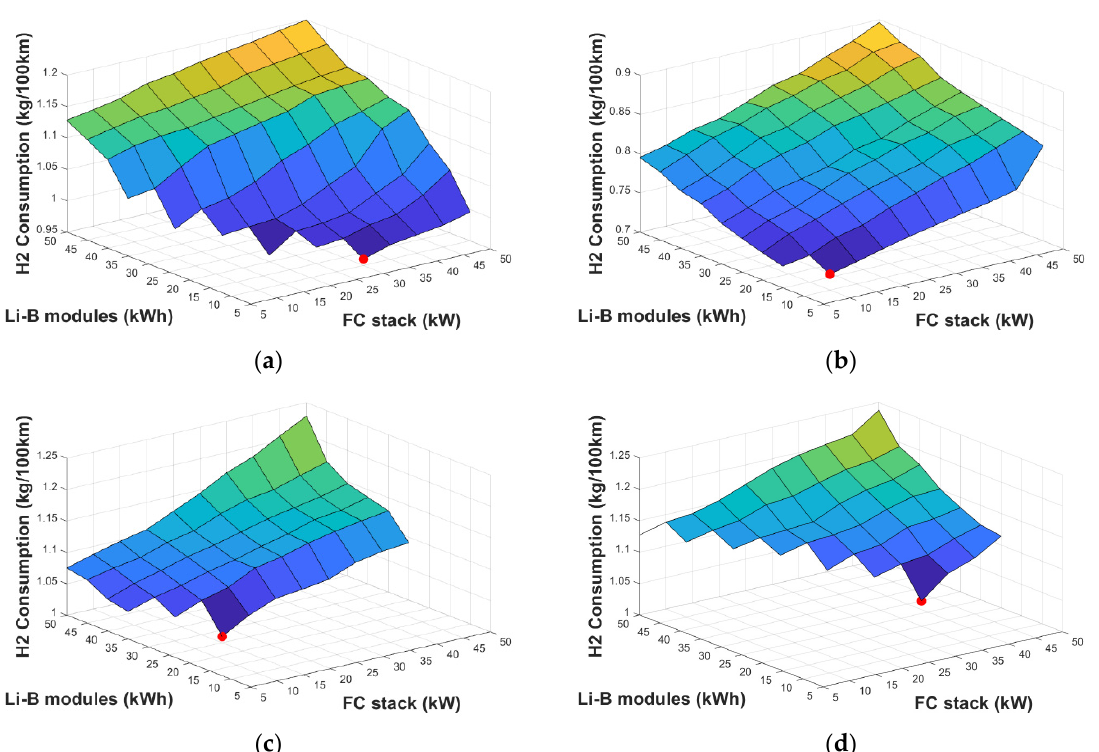
Figure 14. Fuel consumption of the FCV (Psplit1: δ = 1): ( a ) SFUDS, ( b ) FUDS, ( c ) NEDC, and ( d ) WLTP.